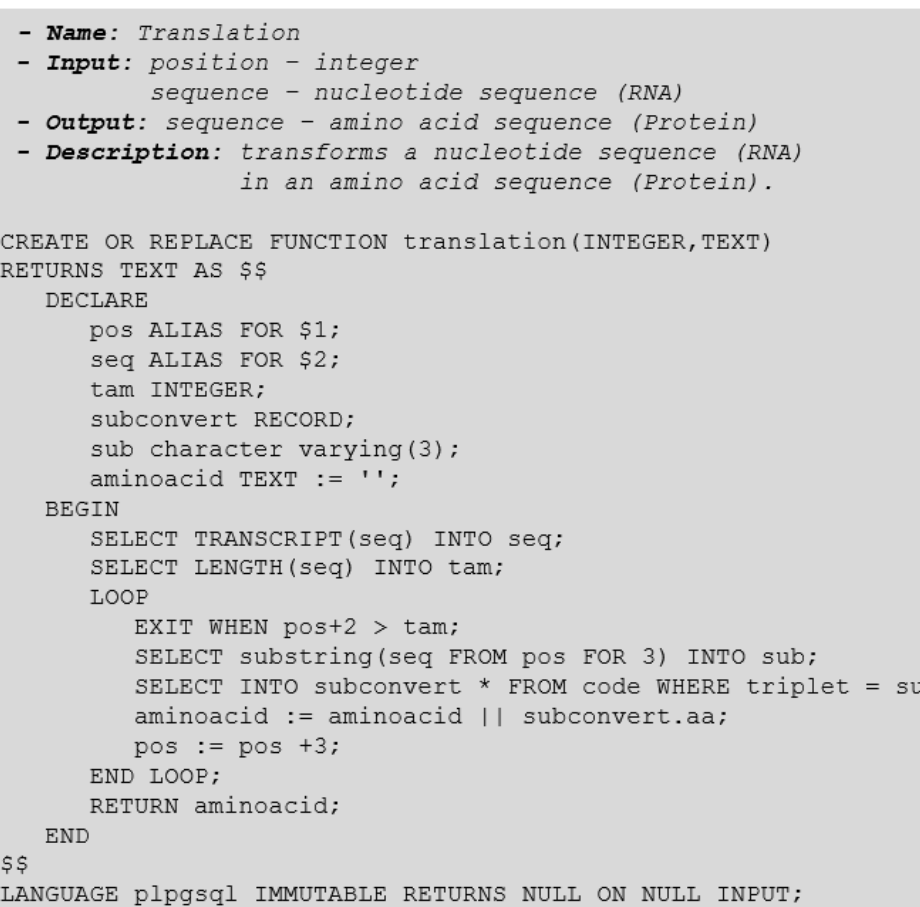
Figure 6. Translation